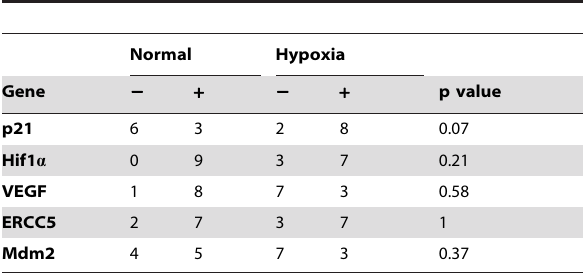
Table 4. Relation of clinical data to genes expression in the presence or absence of hypoxia.